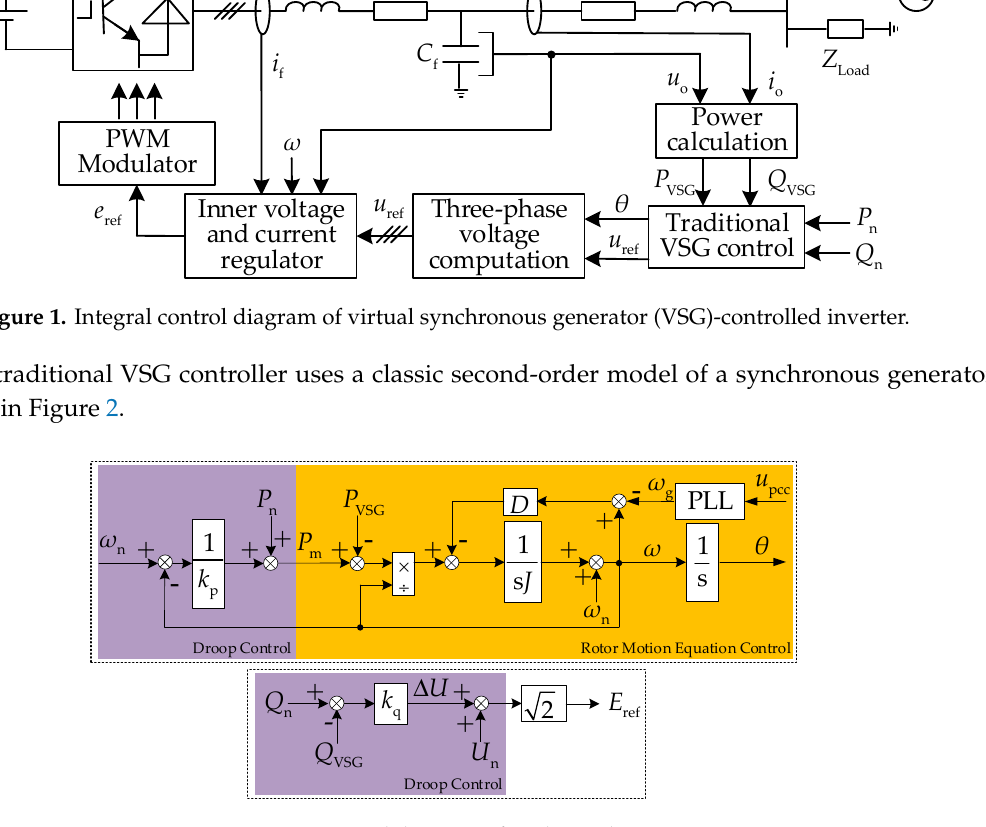
Figure 2. Control diagram of traditional VSG.